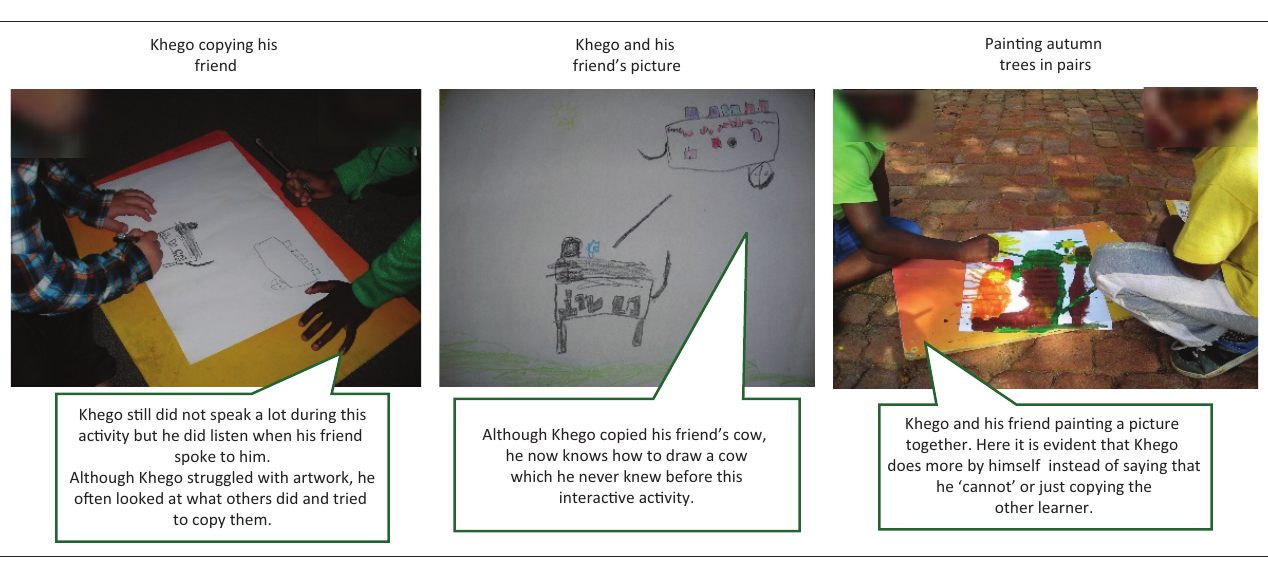
FIGURE 4: Khego gradually became decisive and part of group